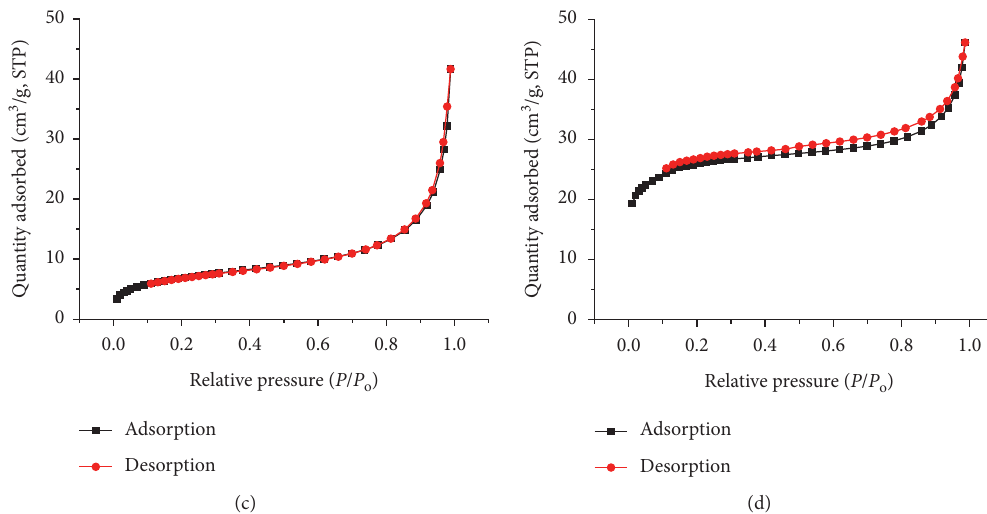
Figure 11: Nitrogen adsorption-desorption isotherms of iron (III) benzene dicarboxylate samples synthesized under different conditions: (a) MeOH, molar ratio of 1:1:400, 150 ° C, and 15h; (b) DMF, molar ratio 1:1:400, 150 ° C, and 15h; (c) DMF, molar ratio 1:1:450, 150 ° C, and 15h; and (d) DMF, molar ratio 1:2:450, 150 ° C, and 24h.